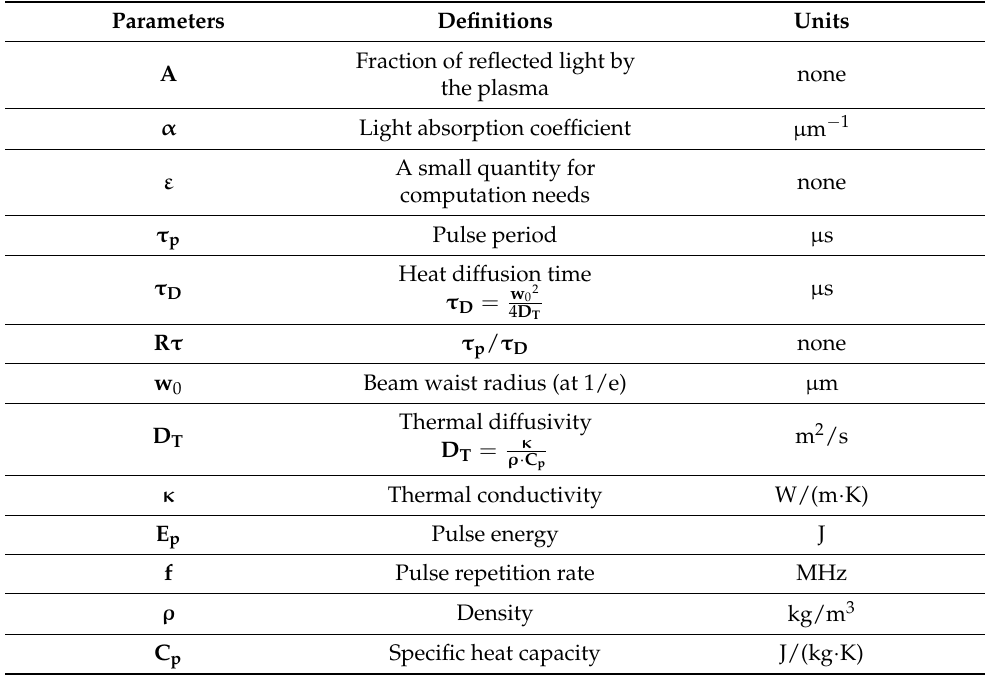
Table A1. Parameters, definitions and units used in the above equations.